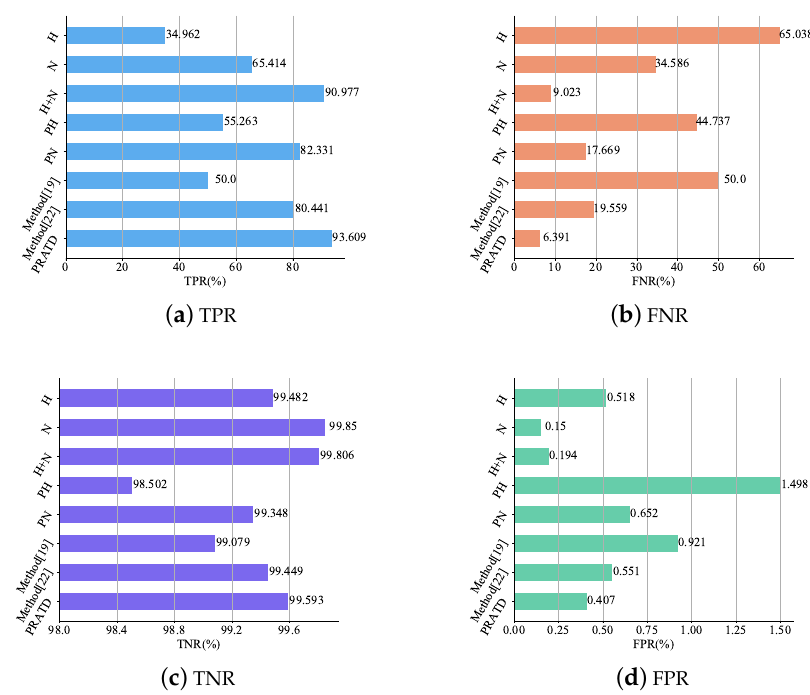
Figure 5. The detection results obtained by the different methods on the known test